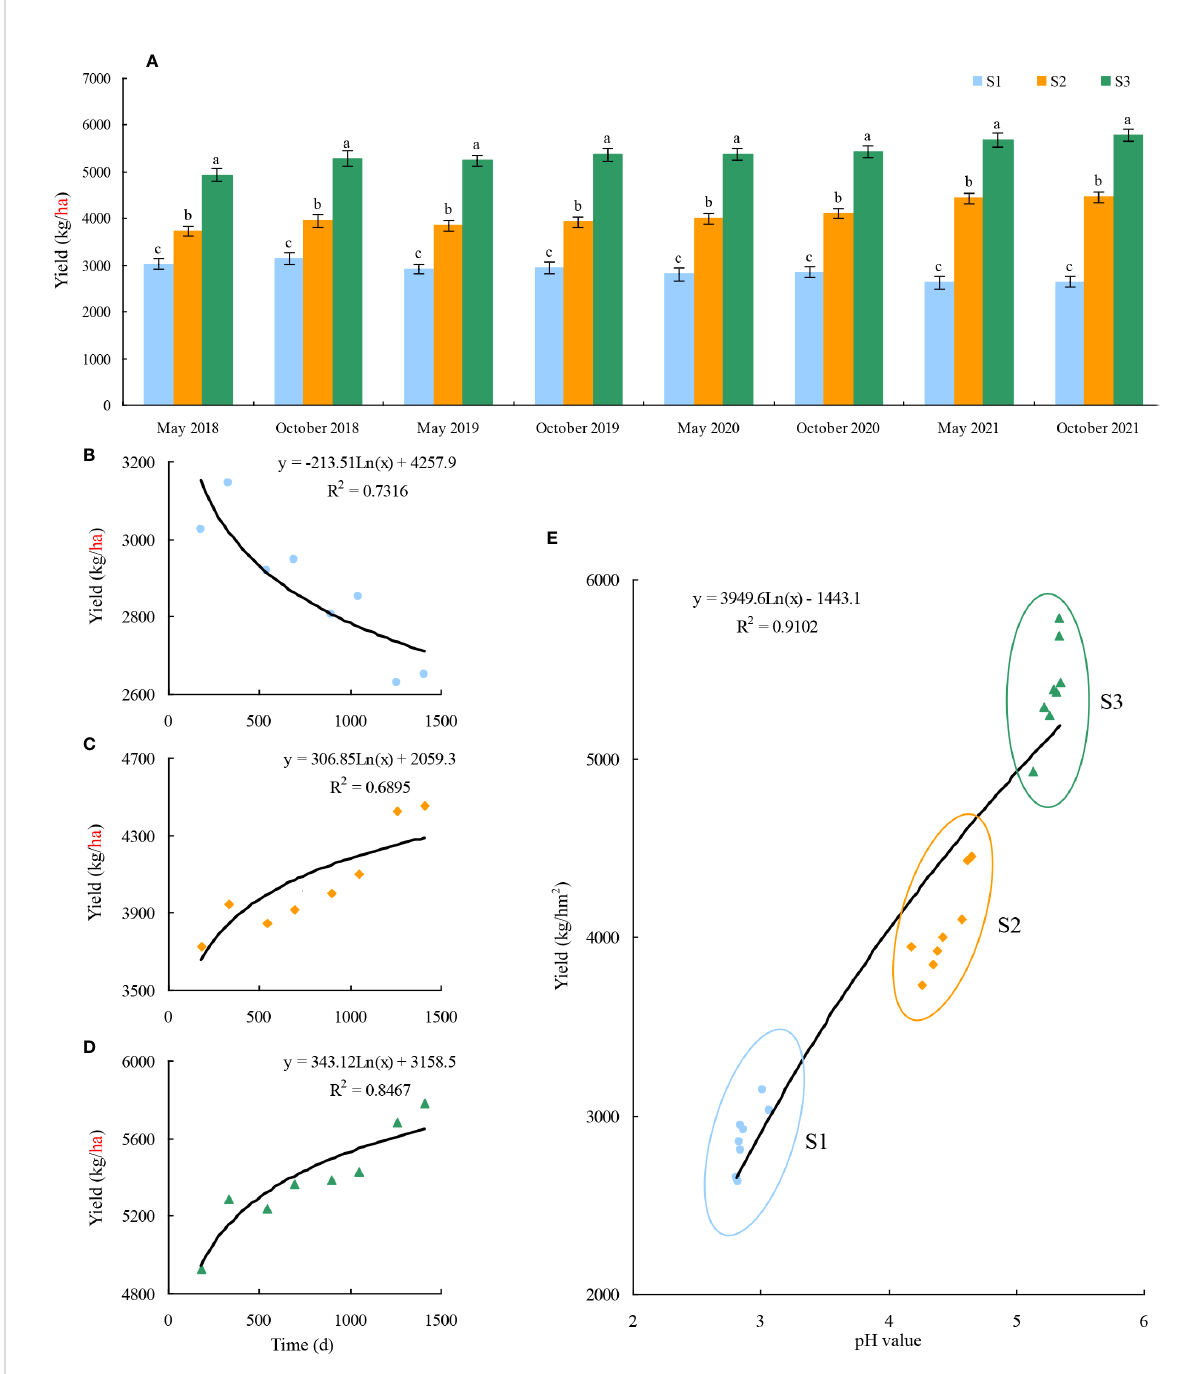
FIGURE 3 Effects of different fertilization treatments and soil pH on tea yield. S1: 100% Chemical fertilizer; S2:50% Organic fertilizer +50% chemical fertilizer; S3: 100% Organic fertilizer; (A) Effect of fertilization treatment on tea yield in four consecutive years; (B) Trend analysis of the effect of continuous treatment for 4 years on tea yield in S1 tea plantation; (C) Trend analysis of the effect of continuous treatment for 4 years on tea yield in S2 tea plantation; (D) Trend analysis of the effect of continuous treatment for 4 years on tea yield in S3 tea plantation; (E) : Trend analysis of in fl uence of soil pH on the tea yield. Different lowercase letters indicate the signi fi cant difference at P < 0.05 levels among different